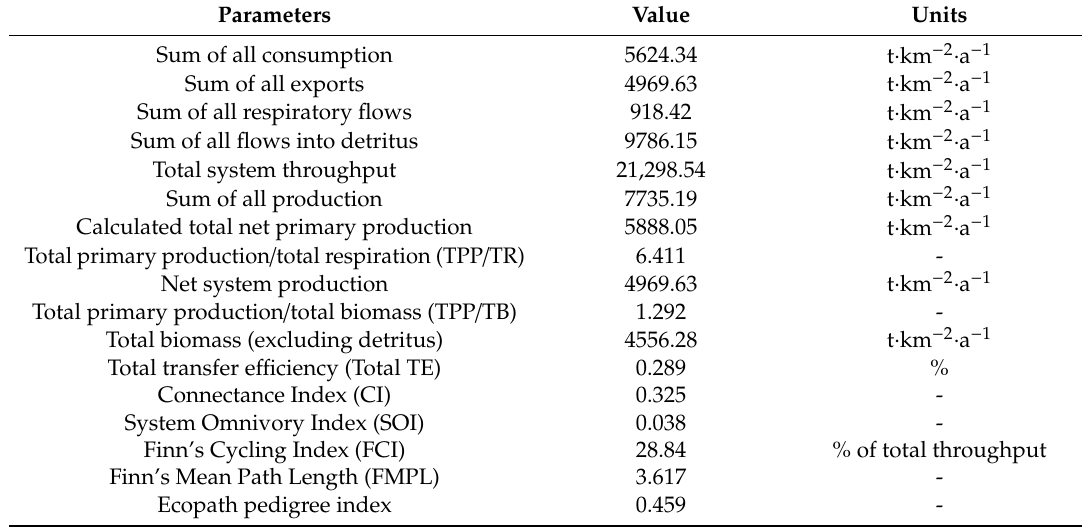
Table 5. Summary statistics and key indicators of the Lake Datong ecosystem.